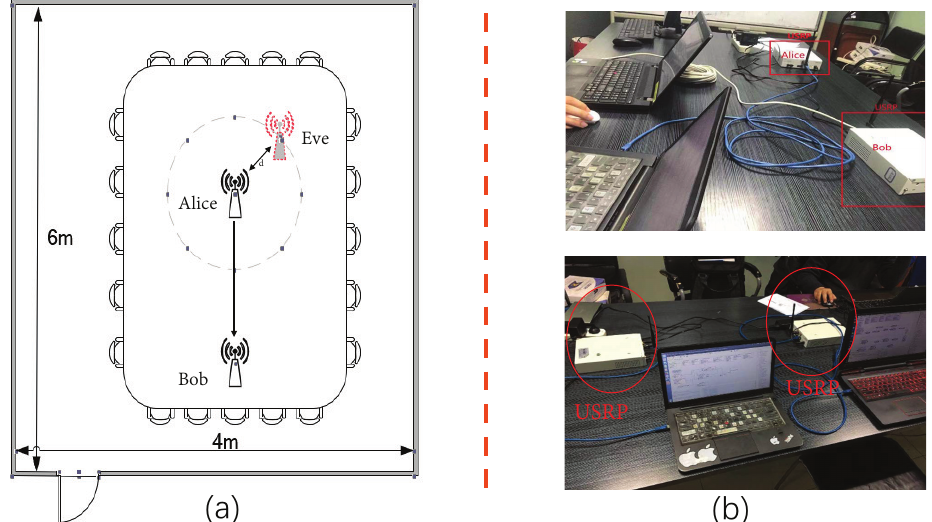
Figure 2. ( a ) Floor plan of the meeting room for data collection. ( b ) Realistic data acquisition scenarios.